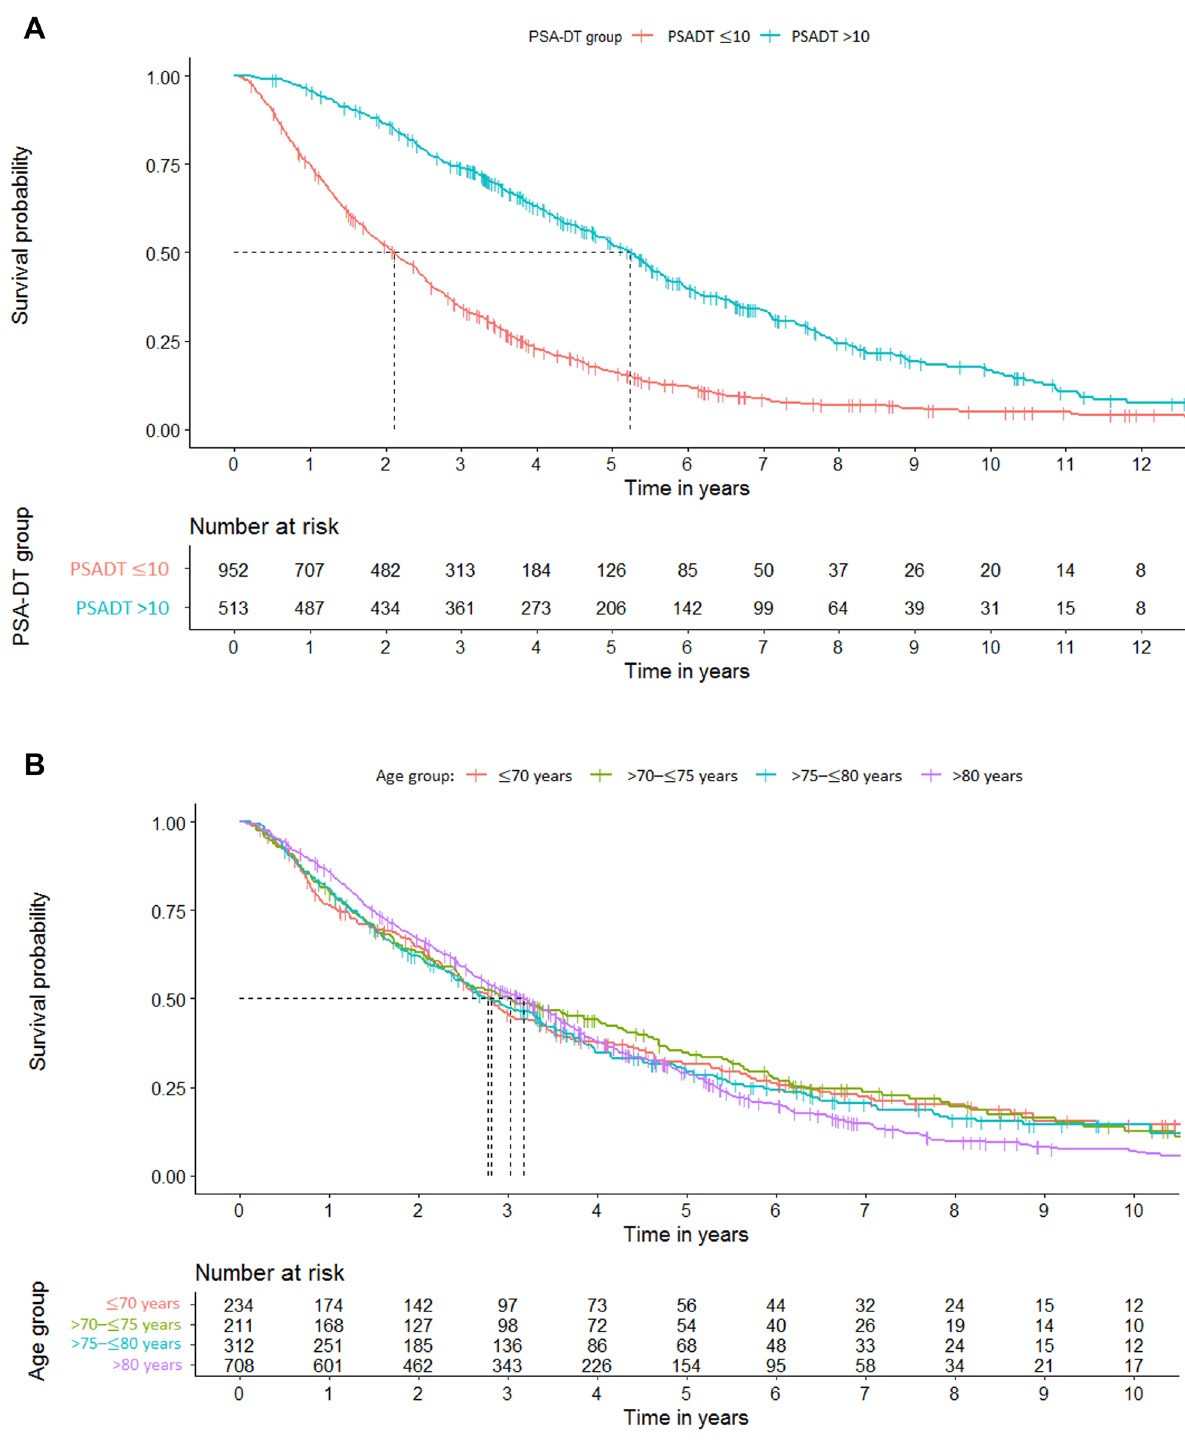
Figure 5. Time to metastases or death, stratified by a) risk group and b) age group. Risk was categorized into two groups, defined as those with a PDADT of either ≤ 10 months or > 10 months. PSA: prostate-specific antigen; PSADT: prostate-specific antigen doubling